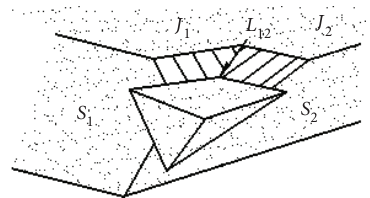
Figure 9: Model of bilateral sliding